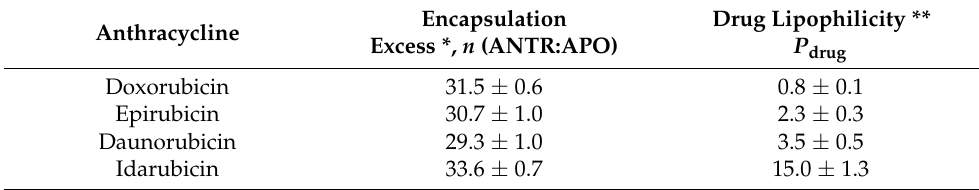
Table 1. The encapsulation excess n for ANTR derivatives in APO nanocages, obtained using encapsulation solutions of 1 mg/mL of APO with ANTR:APO molar ratios of